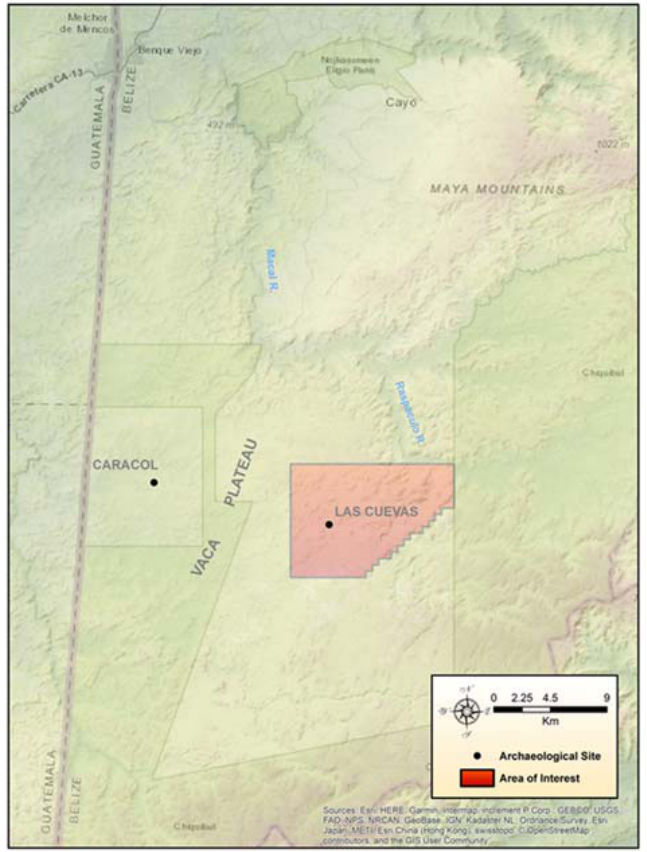
Figure 2. Map of Las Cuevas site illustrating cave system running beneath surface architecture (image courtesy of LCAR).